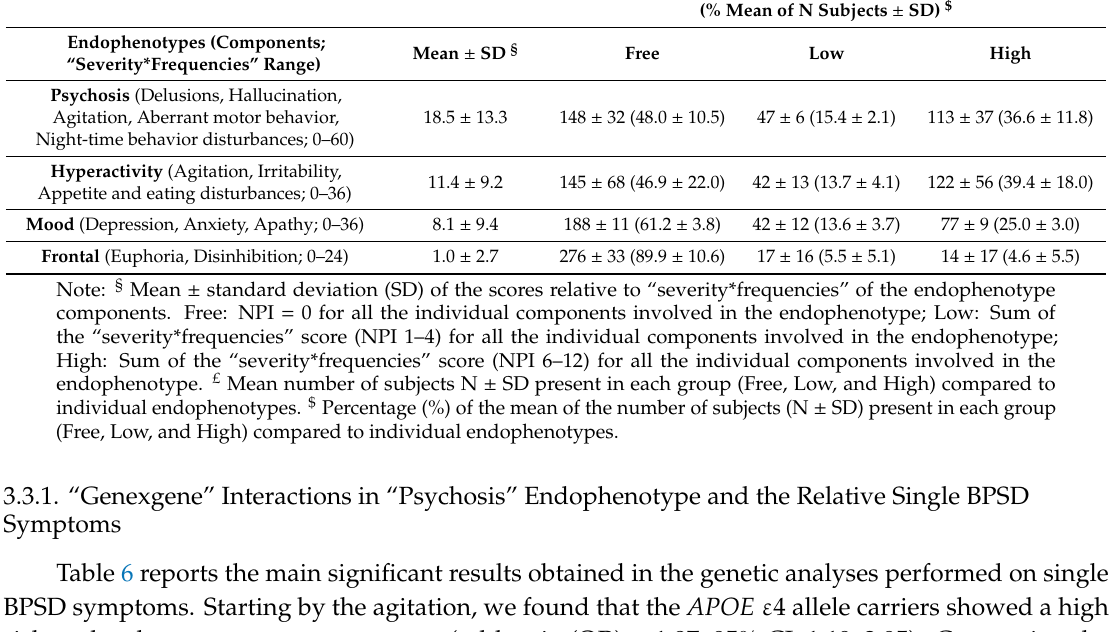
Table 5. Clinical distributions of behavioral endophenotypes in our Italian Alzheimer’s Disease cohort. Mean of N Subjects ± SD £ (% Mean of N Subjects ± SD) $ Endophenotypes (Components; Mean ± SD § Free “Severity*Frequencies” Range)